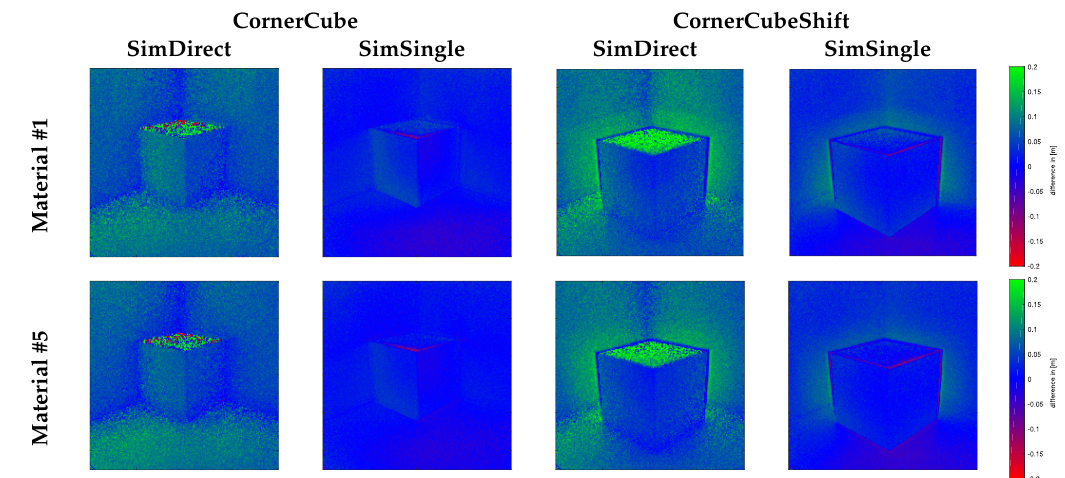
Figure 7. Signed difference images to the CamCube measurement for CornerCube and CornerCubeShift : GroundTruth (Left) and the simulation with direct illumination ( SimDirect , middle) and with single bounce reflection ( SimSingle , Right) for Material #1 (top row) and Material #5 (bottom).